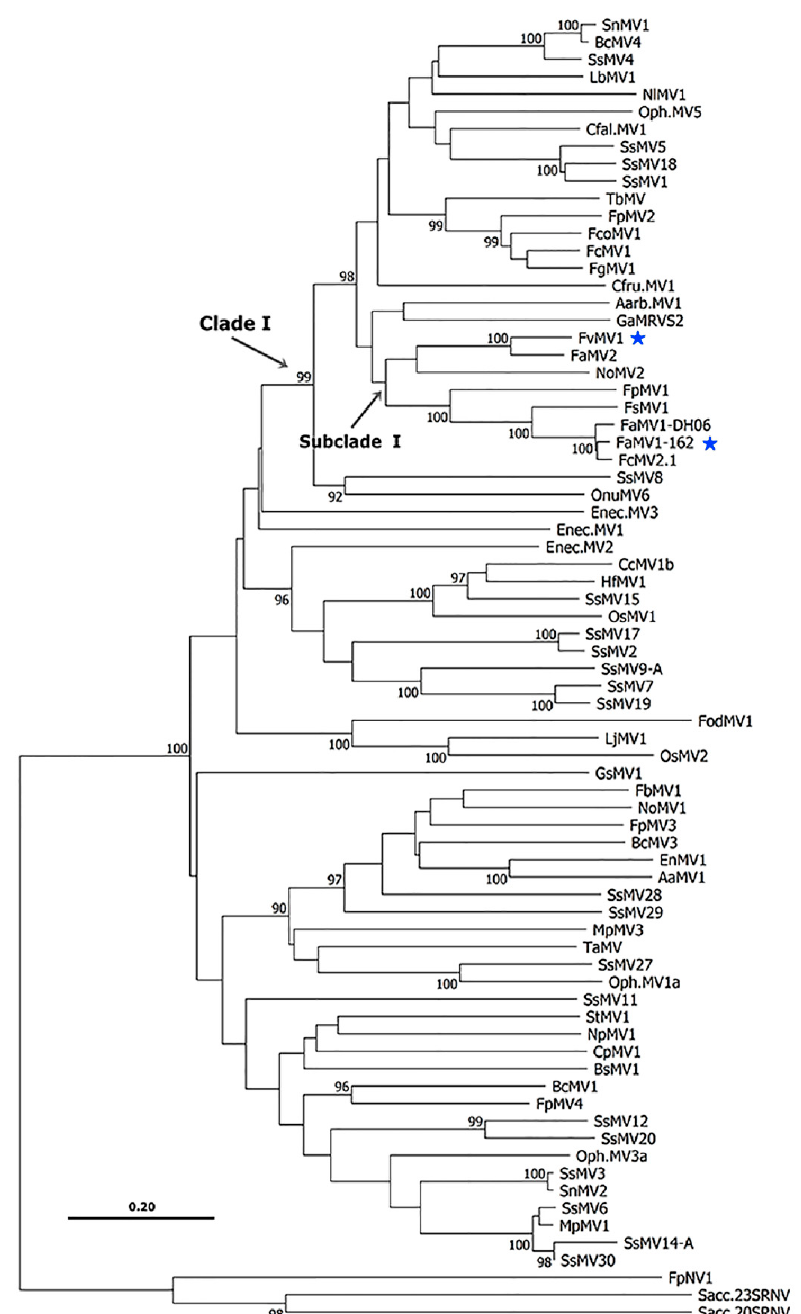
Figure 3. Phylogenetic analysis of mitoviruses ( Mitoviridae ) isolated from fungi of the Ascomycota phylum. The tree is displayed as a rectangular phylogram of 73 mitoviruses and rooted on the branch to members of the genus Narnavirus (Narnaviridae) as external group (FpNV1: